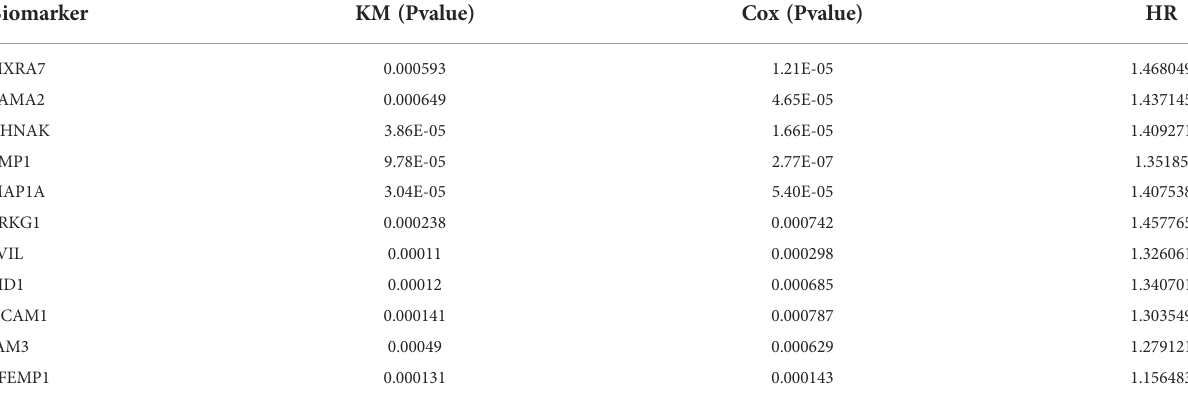
TABLE 1 Results of survival analysis by the KM methodology and the Cox regression approach.